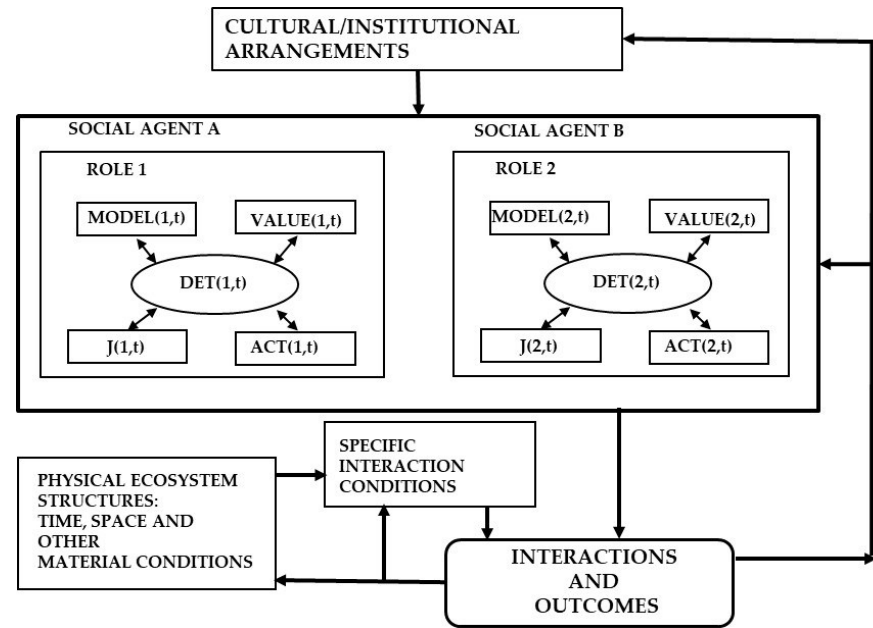
Figure A1. Two Role Model of Interaction Embedded in Cultural-Institutional and Natural Contexts.